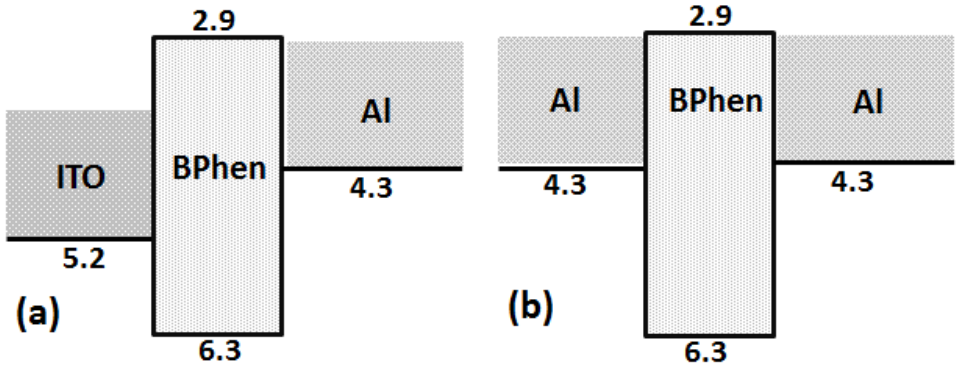
Figure 6. Schematic energy diagram of devices with the following device structure: ( a ) ITO/BPhen/Al; and ( b ) Al/BPhen/Al.